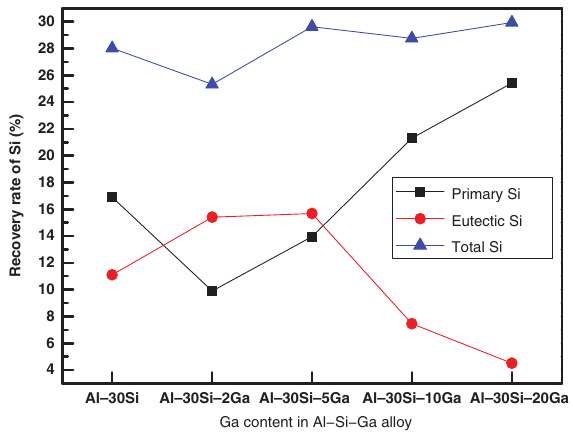
Figure 8: Relationship between Ga content in Al – Si – Ga alloy and recovery rate of Si.